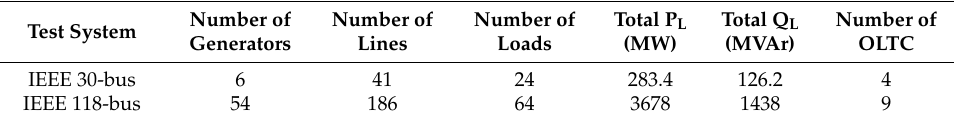
Table 1. Important information of IEEE 30-bus and IEEE 118-bus test systems.